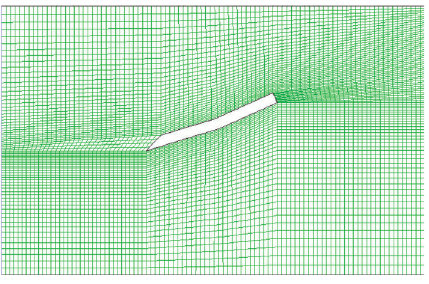
Figure 8: Final grid generation for two-dimensional blade cross- section H.